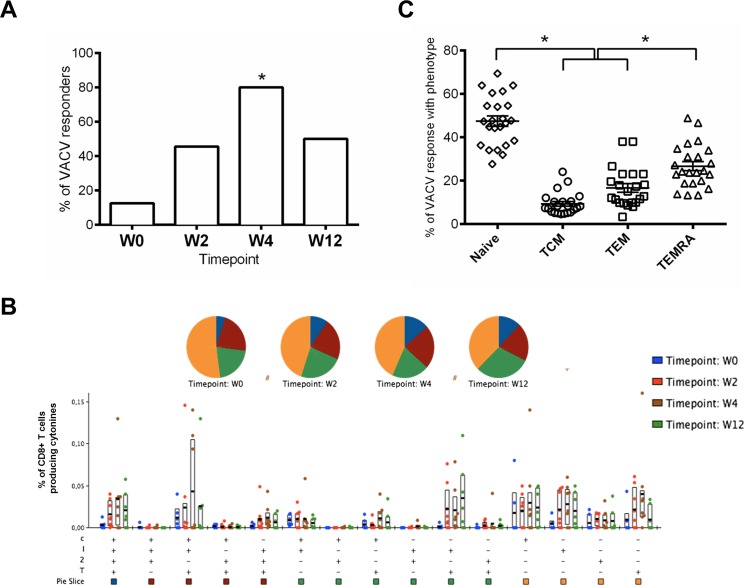
Frequency, function and phenotype of VACV-specific CD8 T cell responses.A: Percentage of responders with positive ICS responses against MVA infected cells at the different time points. The equality of proportion between groups was determined using the function prop.test. *p = 0.017. B: Functional profile of VACV-specific CD8 T cells. The quality of the VACV-specific CD8 T cell response is characterized by the proportion of cells making every possible combination of the measured cytokines: IFN-γ (I); IL-2 (2); TNF-α (T) and CD107a (C). Responses are grouped and colour coded on the basis of the number of functions. The bar charts show the mean values and interquartile ranges (IQR) and the pie charts show the average proportion of the VACV-specific CD8 T cell responses according to the functions at weeks 0, 2, 4 and 12. “+”distributions that are different from the earliest time point (W0) within each category at p<0.05 using Student's T test or “#” Wilcoxon signed rank test. C: Phenotype of VACV-specific CD8 T cells. The graphic represents the distribution of the VACV-specific CD8 T cells at any time point based on CCR7 expression in combination with CD45RA within the Naïve (CD45RA+ CCR7+), T central memory (TCM: CD45RA- CCR7+), T effector memory (TEM: CD45RA- CCR7-) or terminally differentiated T effector memory (TEMRA: CD45RA+ CCR7-) phenotypes. Statistical differences were determined using ANOVA test (using the linear model y ~ x_patient + x_cellType + epsilon) followed by Tukey's honest significant difference criterion. *p<0.05.